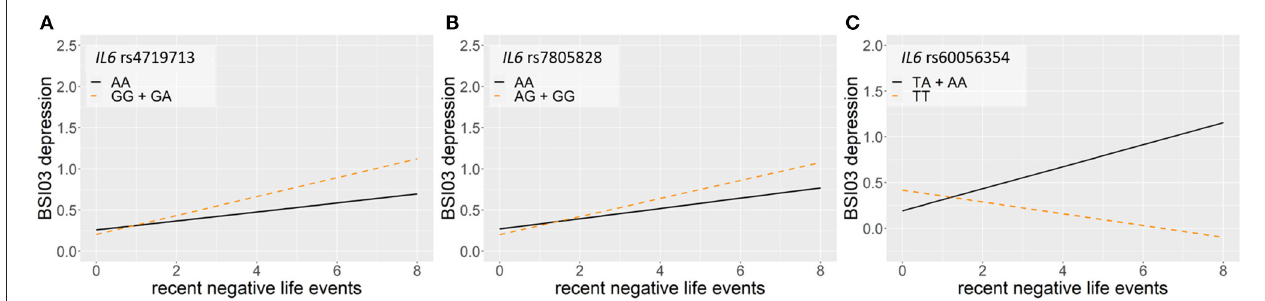
FIGURE 5 | Linear regression models on the interaction between IL6 and recent negative life events (RLE) on current suicidal ideation (SI-BSI03) yielded three significant clumps. In the dominant model, a clump containing seven SNPs with top SNP rs4719713 and the minor G allele as a risk allele was identified ( p = 0.0003) (A) . In the recessive model, one identified clump contained 4 SNPs with top SNP rs7805828 and the minor A allele as a protective allele (9 = 7.39 × 10 − 5 ) (B) ; while the other clump contained six SNPs with top SNP rs60056354 and the minor T allele as a protective allele ( p = 0.0007) (C) . The figure was generated for illustration purposes using R.